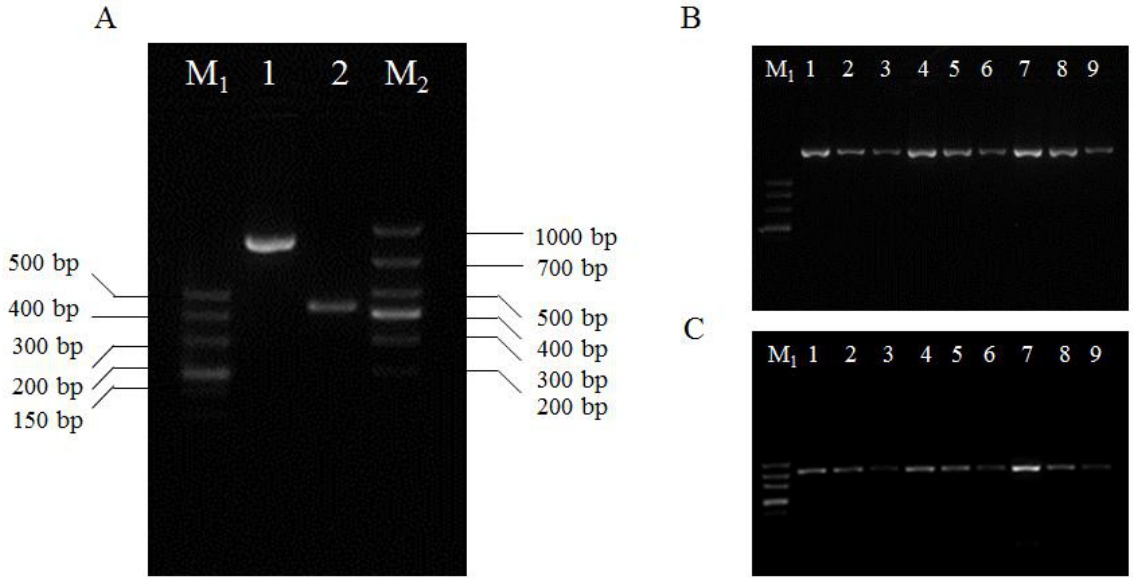
Figure 7. Demonstration test of IC-RT-PCR against a positive blot in the DIBA assay around the PVDF. “M ” and “M ” represent the DNA molecular weight marker (DL500 1 2 and DL1000 Marker, TaKaRa, Dalian). Part A : Lane 1 and 2 represent the gene product of S5 and S10. Part B and C : Lanes “1–3”, “4–6” and “7–9” represent the SRBSDV-infected rice from the greenhouse at three dilution folds: 10×, 100×, and